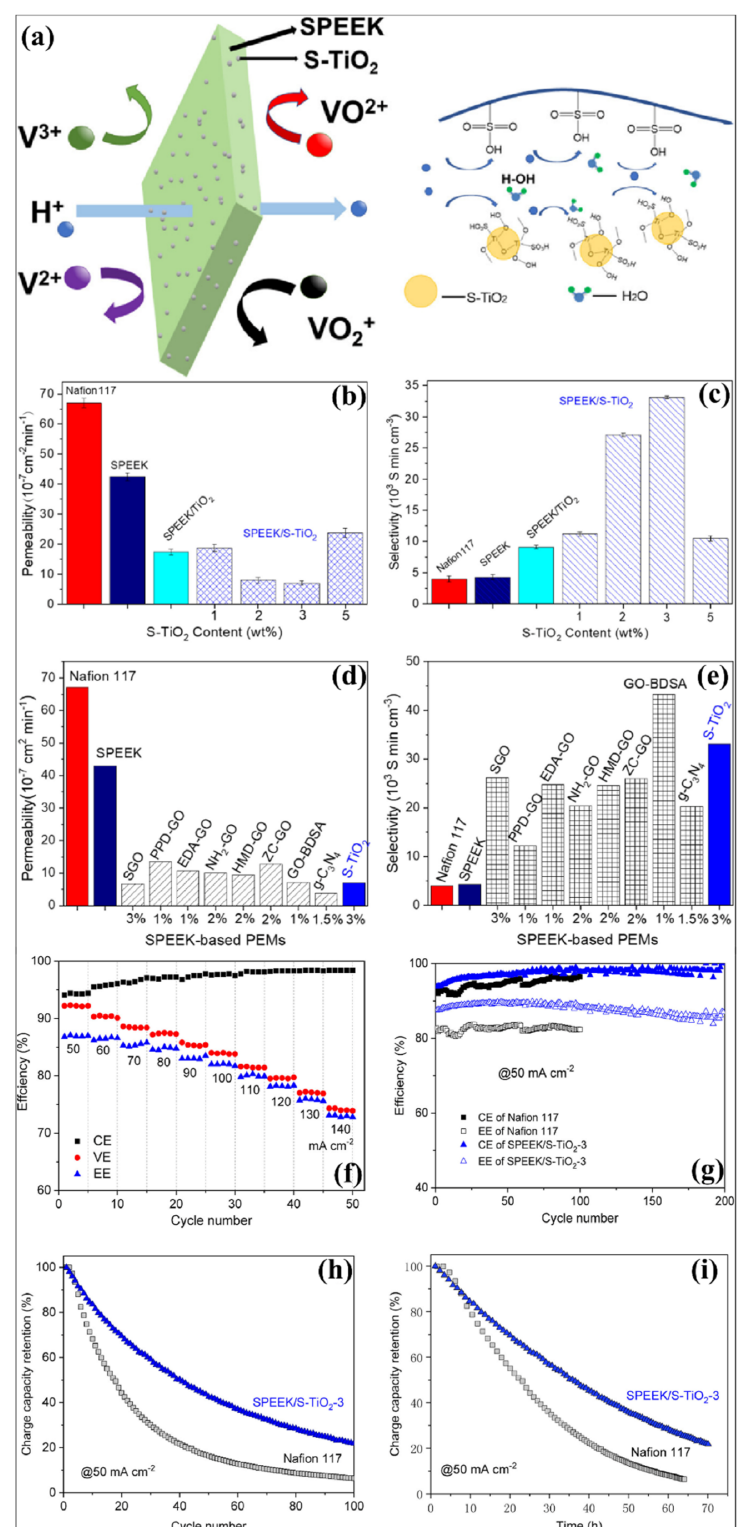
Figure 7. ( a ) Schematic representation of proton transport mechanism in the sPEEK-sTiO 2 membrane. ( b ) Vanadium ion permeability and ( c ) selectivity of sPEEK membrane with different loading of sTiO 2 . ( d ) Vanadium ion permeability and ( e ) selectivity of sPEEK-sTiO 2 membrane compared with other reported results. ( f – i ) VRFB unit cell performances of sPEEK-sTiO 2 hybrid membrane. Reprinted with permission from ref. [125]. Copyright © 2021 Elsevier Ltd. (License Number: